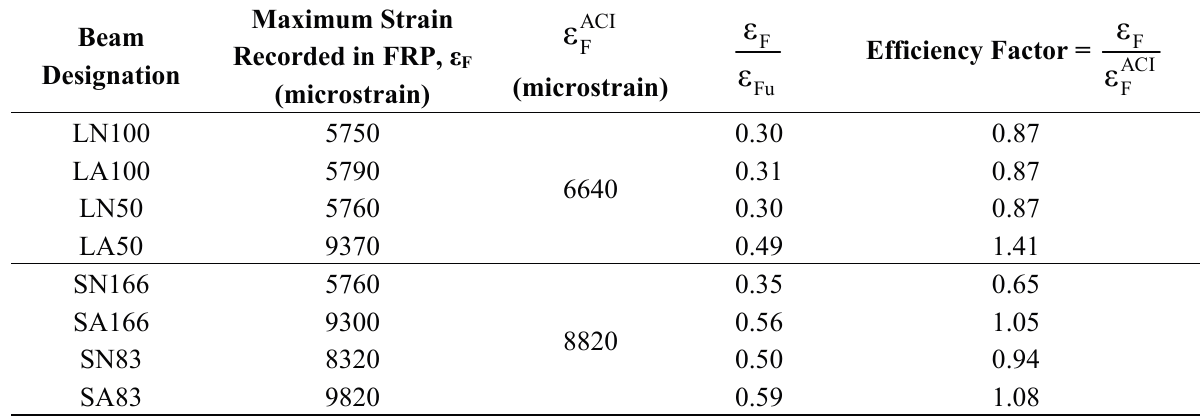
Table 6. Maximum recorded fiber reinforced polymers (FRP) strain in test beams compared to its rupture strain and to the maximum strain allowed by the